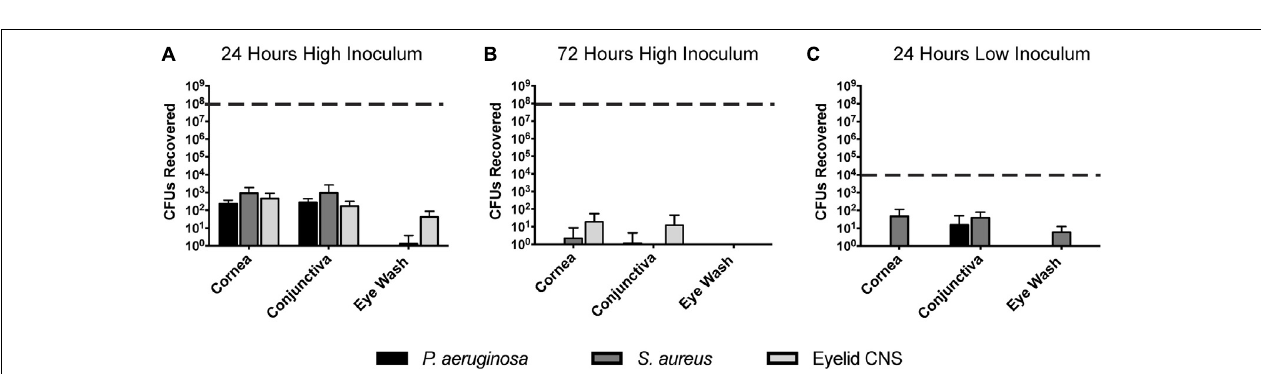
FIGURE 4 | Fluorescence in situ hybridization (FISH) labeling confirms that healthy murine corneas are nearly devoid of viable bacteria. (A) FISH labeling confirmed C57BL/6 mouse corneas host very few viable bacteria. A representative field of view is shown from four different corneas (two male and two female mice). (B) Quantification of viable bacteria on healthy murine corneas using alkDala or FISH expressed as mean ± SD per field of view. One field of view is ∼ 0.04 mm 2 . ns = there was no significant difference between number of bacteria detected by either method ( P = 0.40, Student’s t -Test).